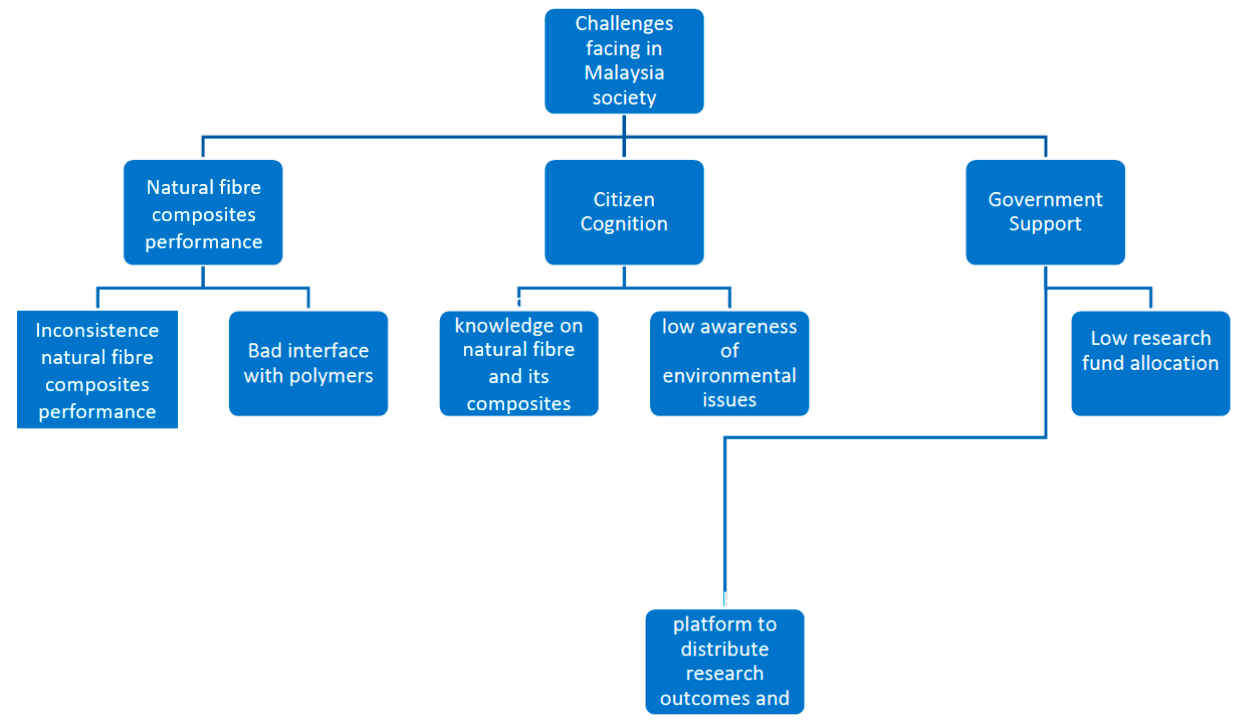
Figure 10. The challenges faced by natural fibre reinforced polymer composites.